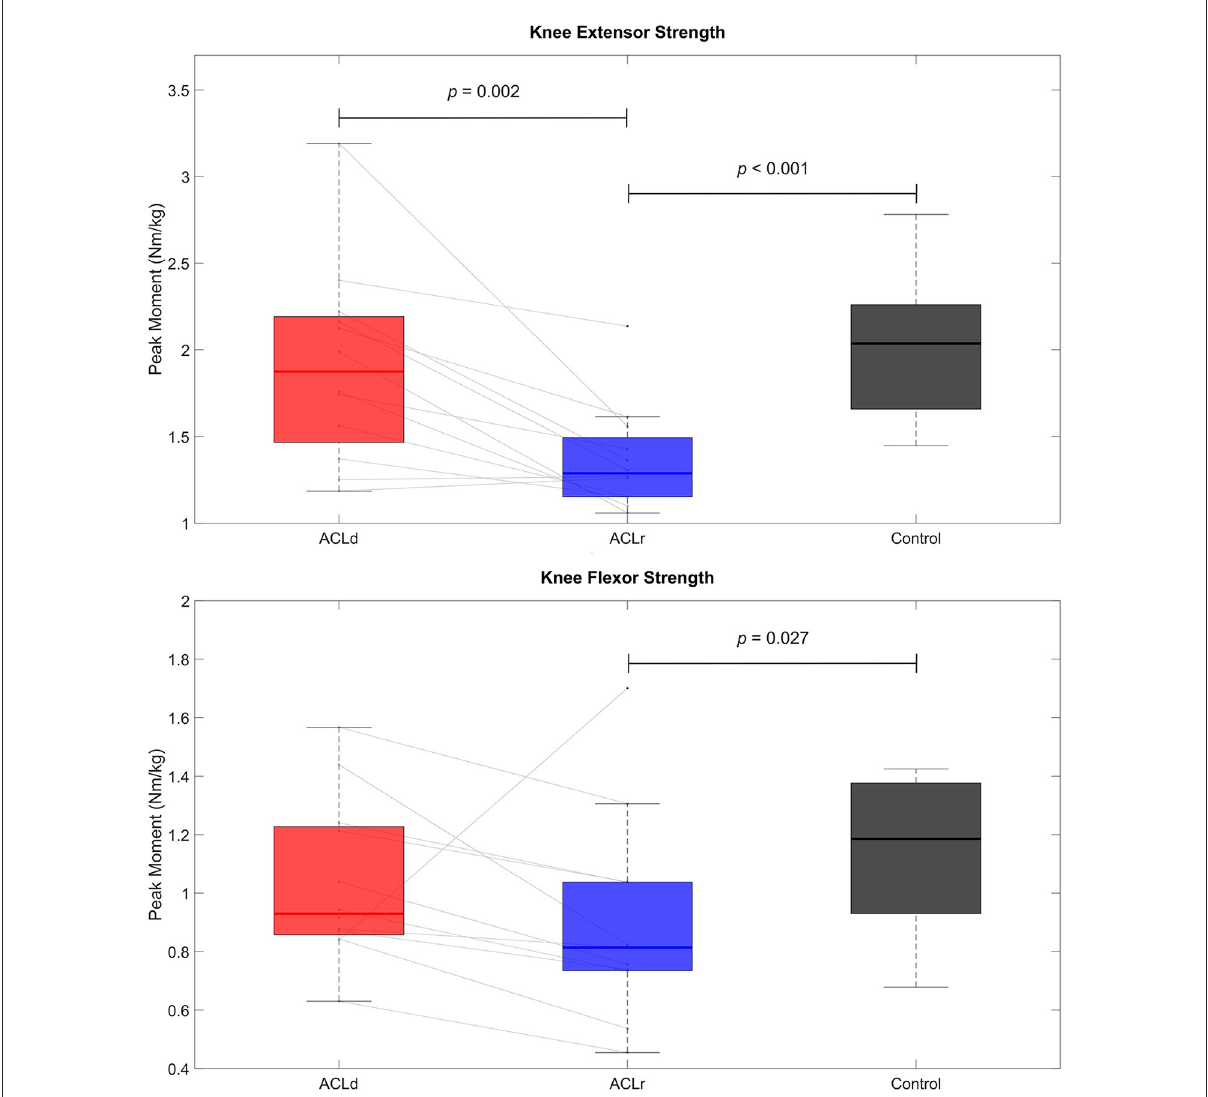
FIGURE2 Knee extensor and flexor muscle strength. Knee extensor strength showed a statistically significant decline from pre to post ACL reconstruction. The patients with an ACL reconstruction were weaker in both knee extensors and flexors than healthy controls.